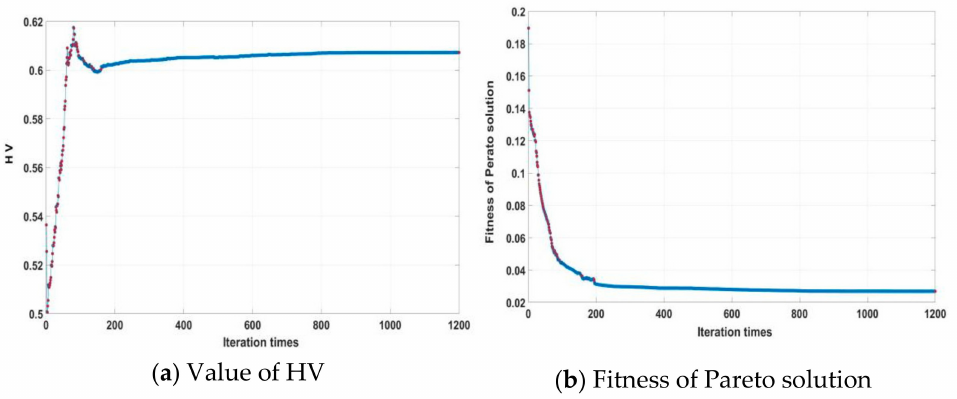
Figure 14. HV index and fitness function change with iteration